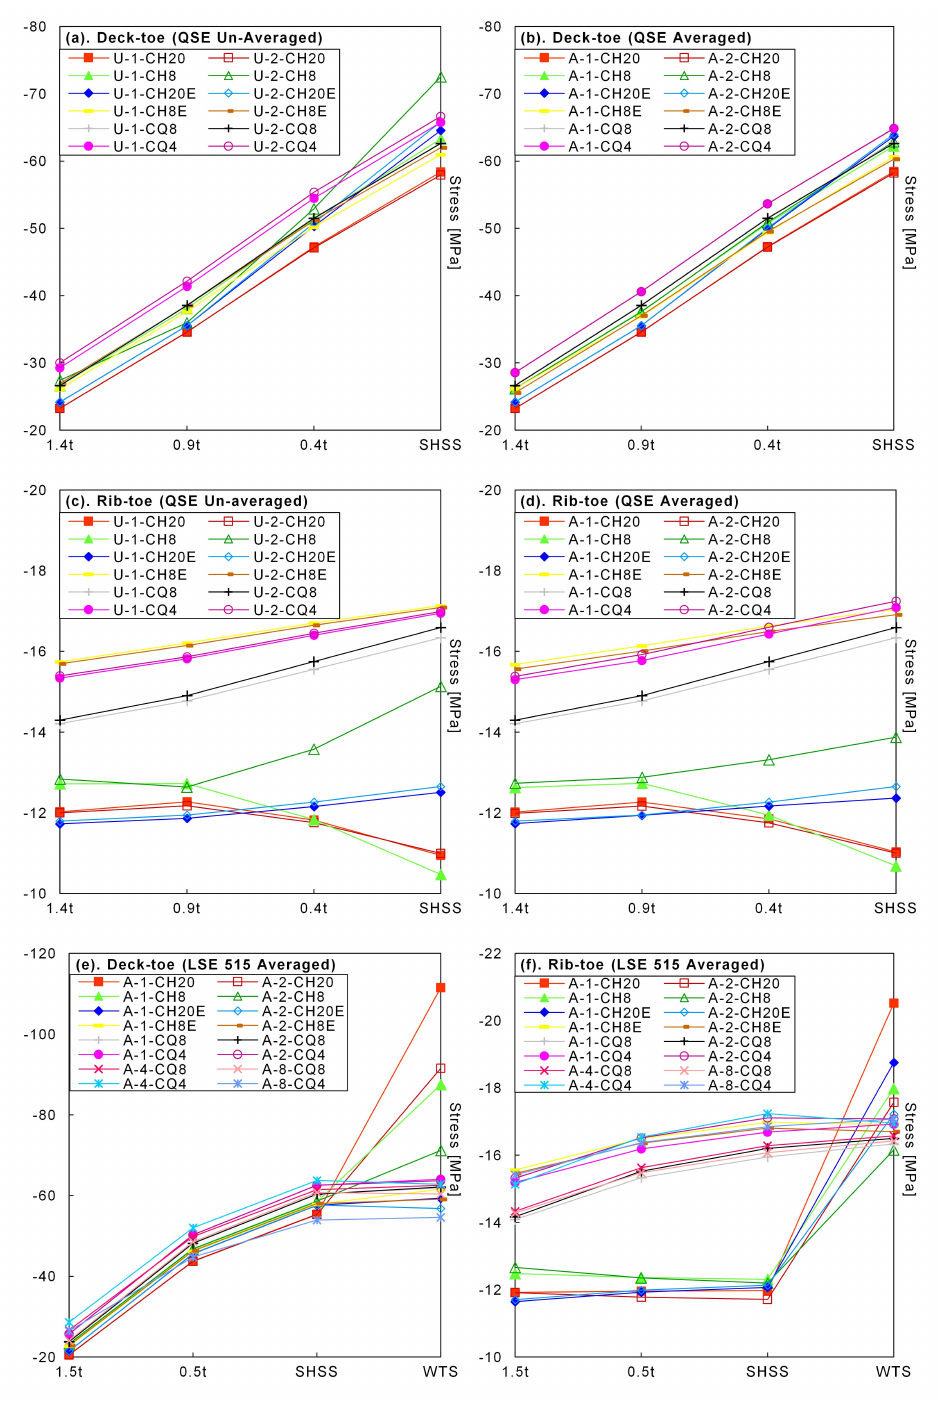
Figure 8. ( a – f ) Principal stress variation in the deck and the rib-plate with weld-toe stresses (WTS) and SHSS at their respective weld-toes considering QSE and LSE 515 reference extrapolation